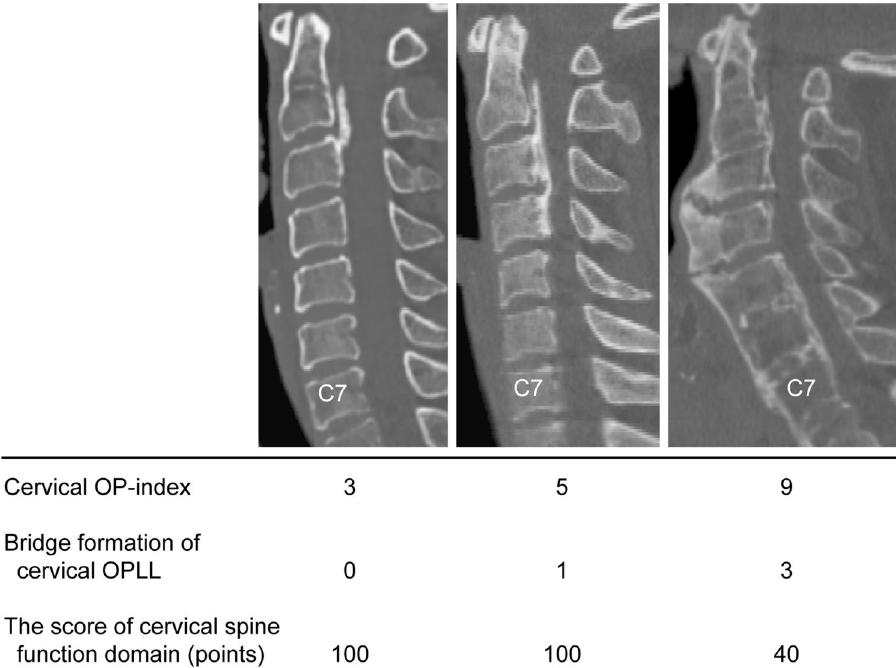
Figure 1. Representative reconstructive mid-sagittal computed tomography image of cervical OP-index and bridge formation of cervical OPLL. The score of the cervical spine function domains of the left, middle, and right images were 100 points, 100 points, and 40 points, respectively. OPLL ossification of the posterior longitudinal ligament; OP-index ossification index for OPLL.